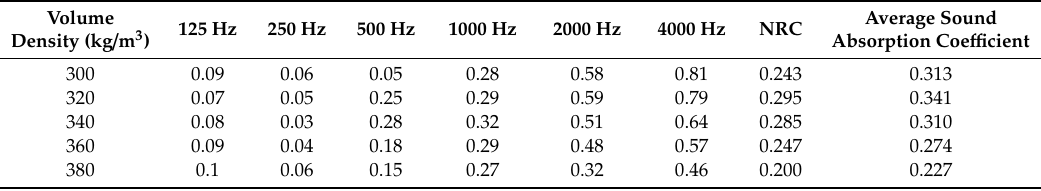
Figure 6. ( a ) Variation of sound absorption coe ffi cient with respect to volume density. ( b ) Change in porosity with respect to volume density [black—measured, red—calculated]. ( c ) Comparison of experimental SAC values with the estimated SAC values using Delany and Bezley model (D&B) and Johnson–Champoux–Allard model (JCA). Table 3. Noise reduction coe ffi cient (NRC) and average sound absorption coe ffi cient for varied volume density